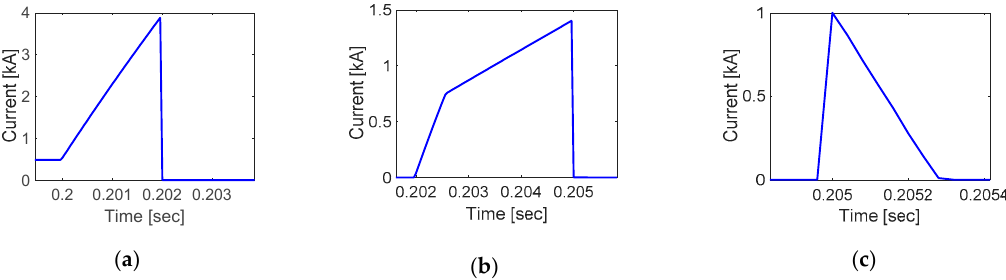
Figure 12. Current through di ff erent branches of breaker: ( a ) main branch; ( b ) FCLC (auxiliary branch);